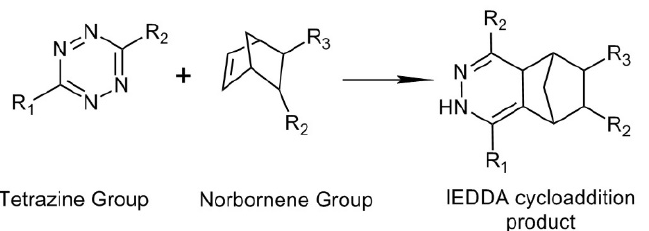
Figure 8. Inverse electron demand Diels–Alder (IEDDA) cycloaddition reaction between tetrazine and norbornene groups.